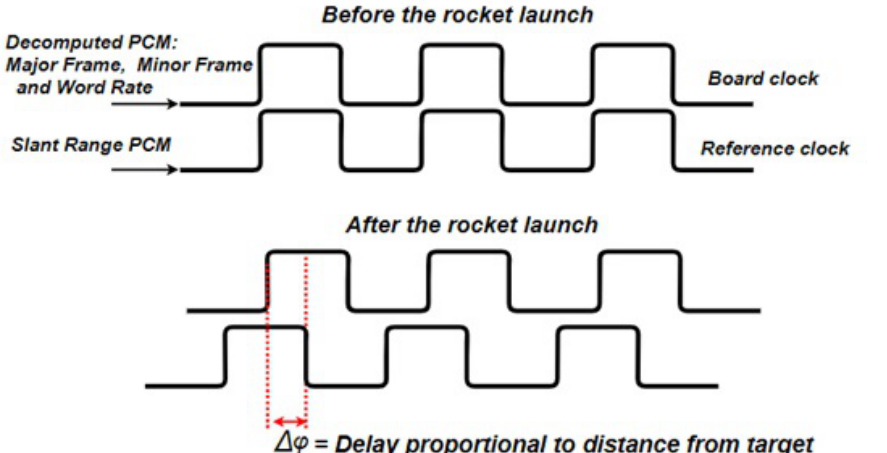
Figure 3. Demonstrates the two instants for the measurement performed by the slope range.